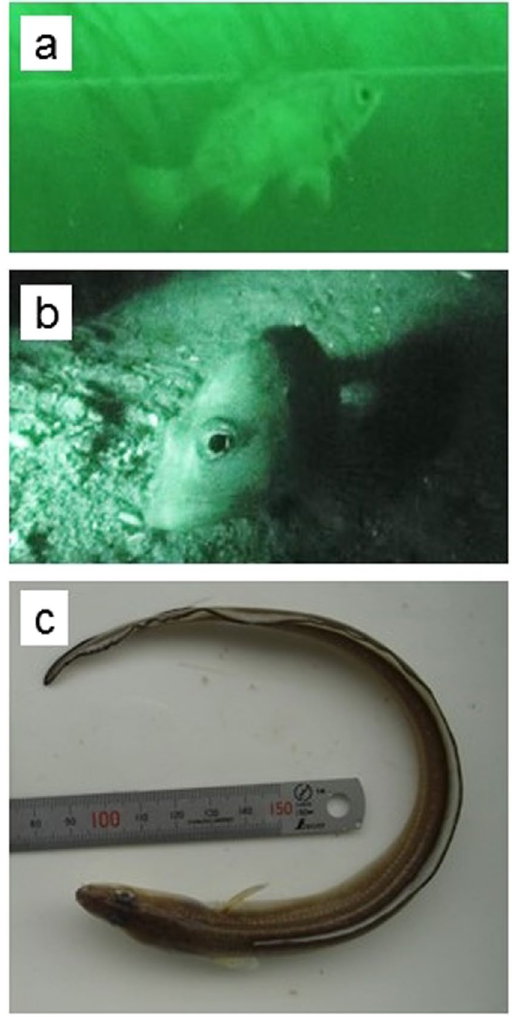
Figure 1. Nocturnal visit of piscivorous fish predators monitored by an underwater video camera with an infra- red light ( a ) black rockfish Sebastes sp., ( b ) marbled rockfish Sebastiscus marmoratus ) and conger eel Conger myriaster ( c ) collected from the seagrass bed during the field